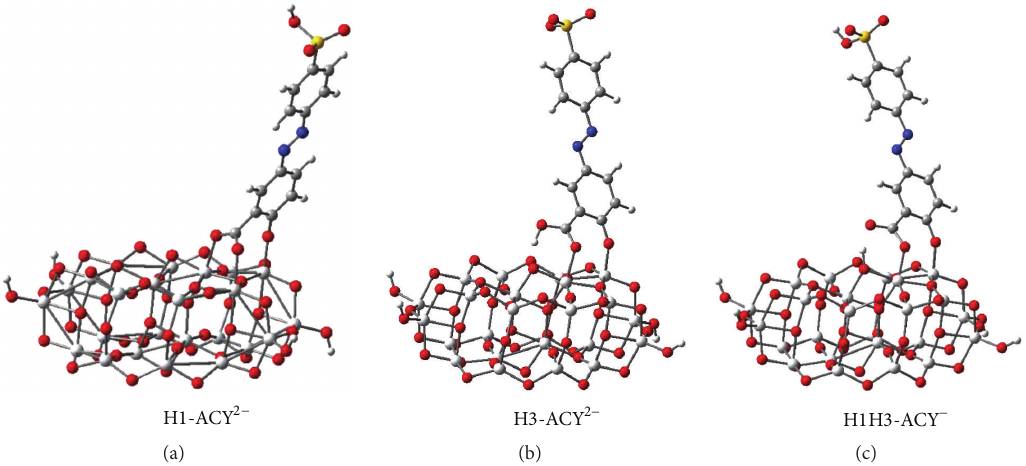
Figure 8: Optimized structure of complex dye-oxide systems with anchoring primarily through the hydroxyl group, calculated at DFT/B3LYP/3-21G(d)